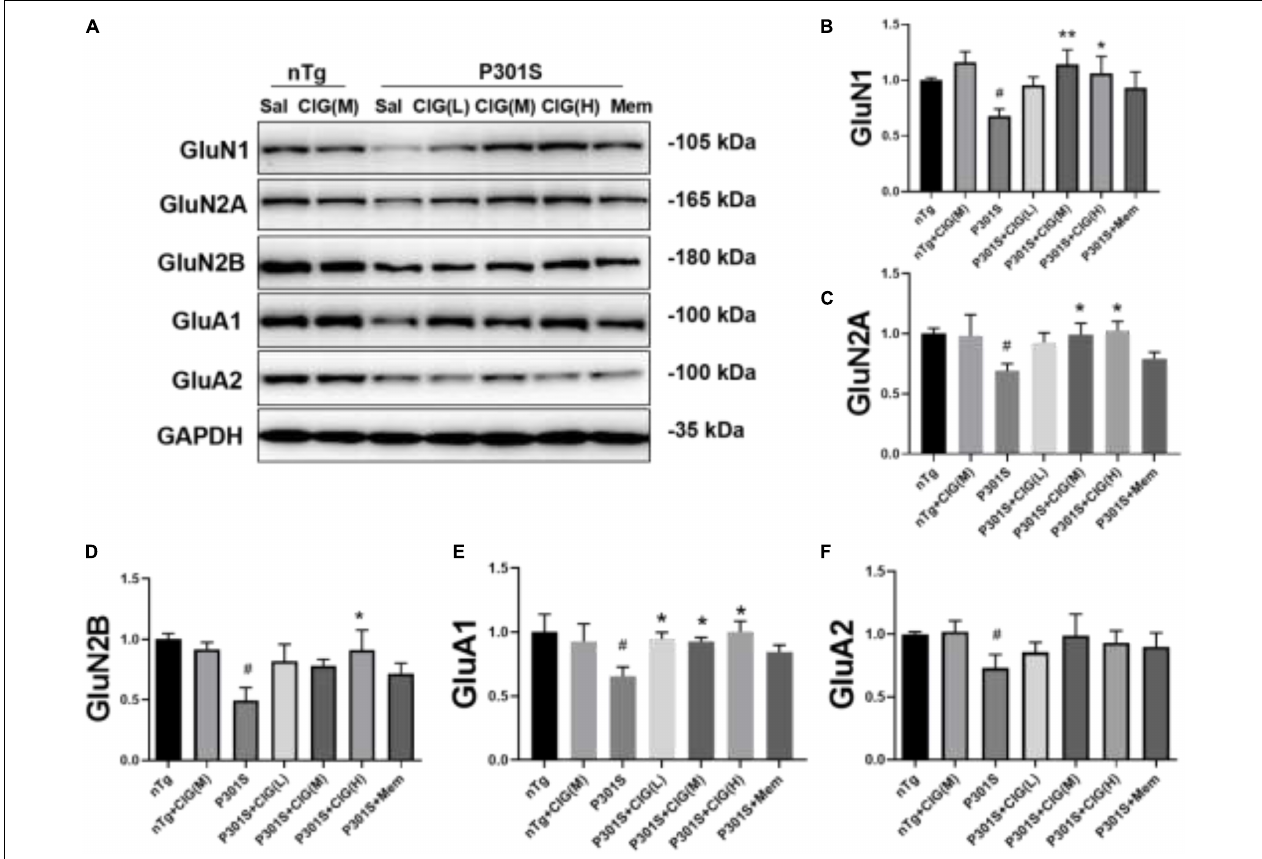
FIGURE 3 | Cornel iridoid glycoside (CIG) increased the expression of NMDARs and AMPARs in the brain of P301S transgenic mice. (A) Representative images of Western blotting for NMDAR subunits GluN1, GluN2A, and GluN2B and AMPAR subunits GluA1 and GluA2 in the brain of mice. Quantification of Western blotting for NMDAR subunits GluN1 (B) , GluN2A (C) , and GluN2B (D) and AMPAR subunits GluA1 (E) and GluA2 (F) in the brain of P301S mice. Quantification of blots after normalization with GAPDH, and the numerical value of nTg group was taken as 1. Data are expressed as mean ± SEM; n = 4 each group. # P < 0.05, P301S transgenic mice vs nTg control mice; * P < 0.05, ** P < 0.01, drug-treated P301S mice vs saline-treated P301S mice. Sal, saline-treated; NMDARs, N -methyl- D -aspartate receptors; AMPARs, α -amino-3-hydroxy-5-methyl-4-isoxazole propionic acid